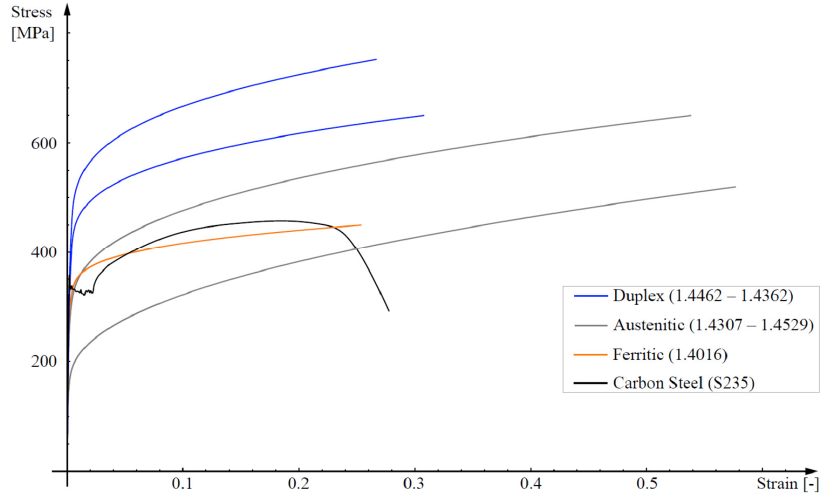
Figure 1. A typical experimental stress–strain curve for carbon-steel S235 (black line) vs. different types of stainless-steel stress–strain curves represented by means of a modified Ramberg–Osgood model [17].